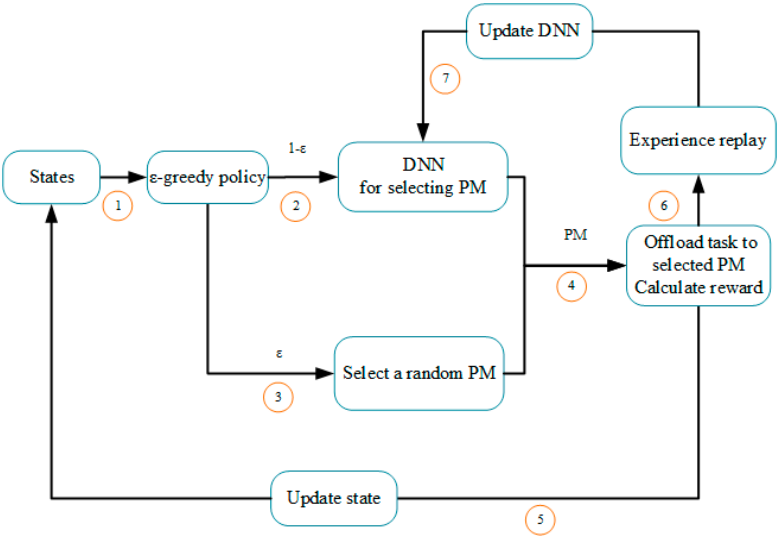
Figure 5. Flow diagram of task offloading algorithm based on deep reinforcement learning (DRL).